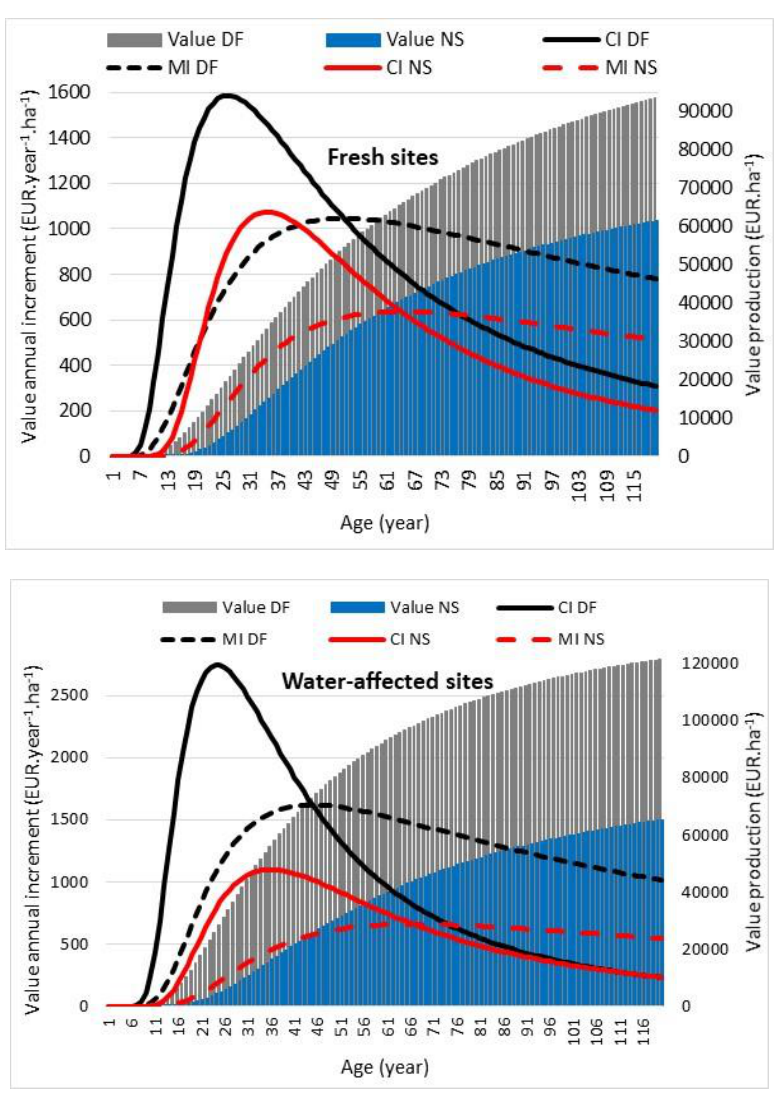
Figure 4. Courses of the current (CI) and mean (MI) value increment of growing stock for Douglas fir (DF) and Norway spruce (NS) in different sites conditions at UFE Kostelec nad Černými lesy, modelled by Korf’s function.